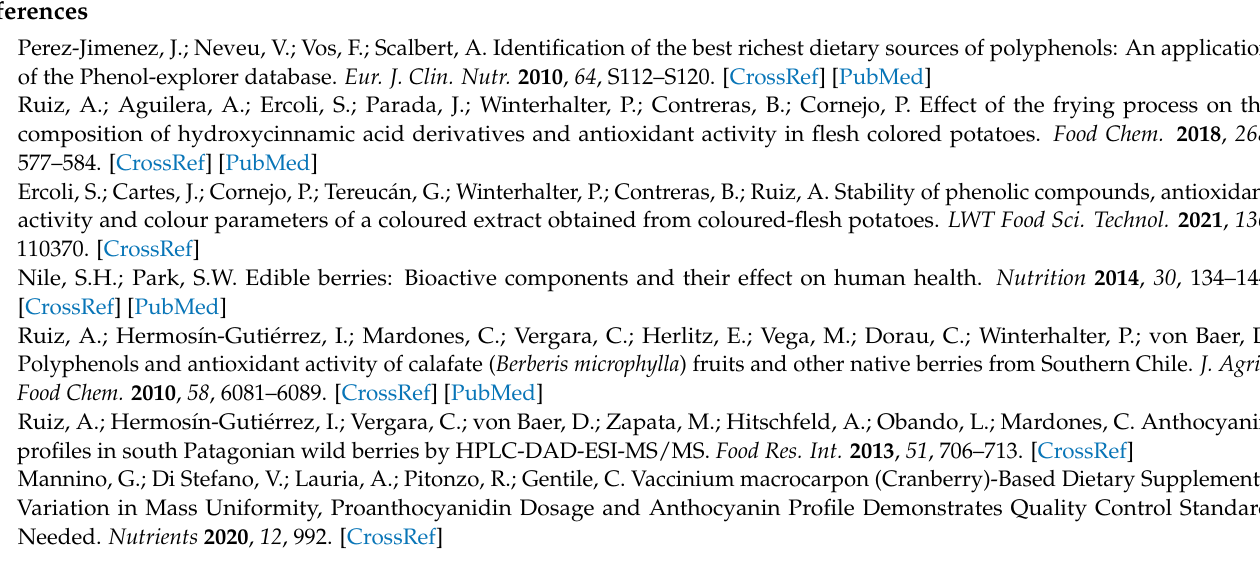
Table S2: Individual anthocyanin concentrations (g kg − 1 fresh weight) by HPLC-DAD in cooked samples of Solanum tuberosum . Table S3: Individual hydroxycinnamic acid derivatives concentrations (g kg − 1 fresh weight) by HPLC-DAD in fresh samples of Solanum tuberosum . Table S4: Individual hydroxycinnamic acid derivatives concentrations (g kg − 1 fresh weight) by HPLC-DAD in cooked samples of Solanum tuberosum